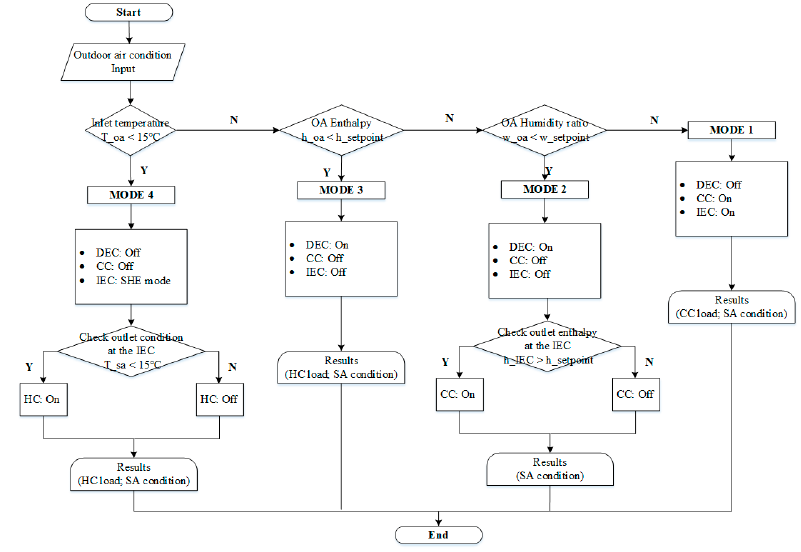
Figure 11. The flow chart of the IDECOAS simulation.